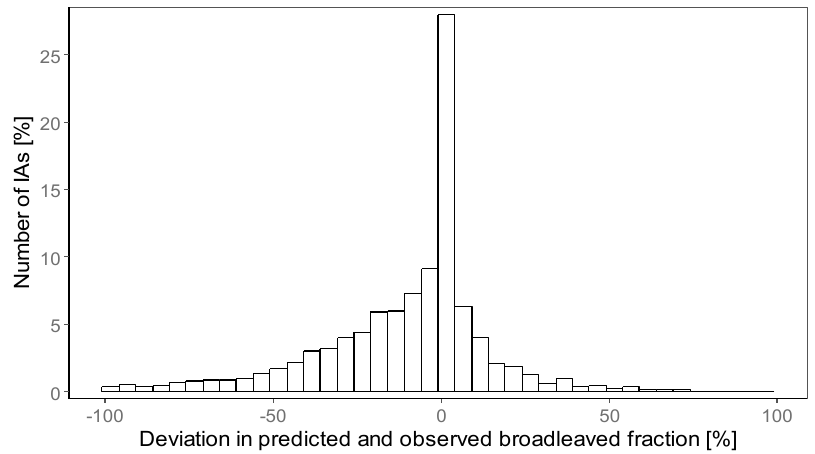
Figure 6. Histogram of the deviation values in predicted (tree type map) and observed (NFI image interpretation) broadleaved fraction in the IAs.